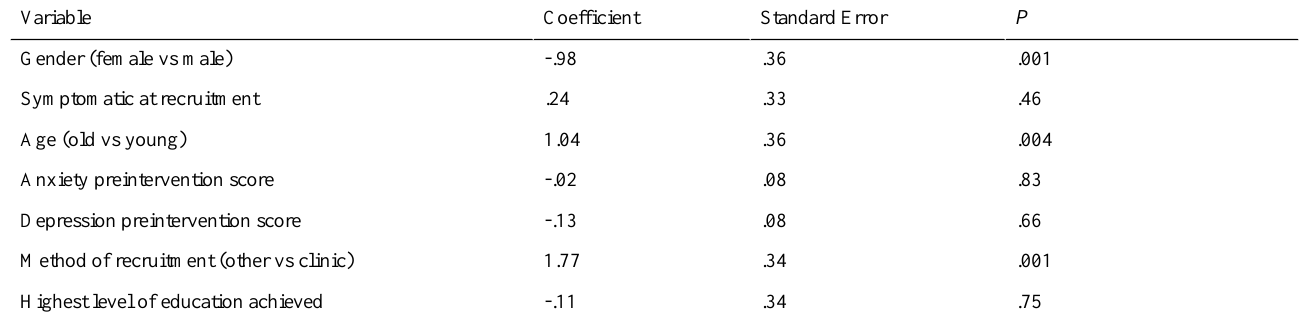
P Standard ErrorCoefficientVariable